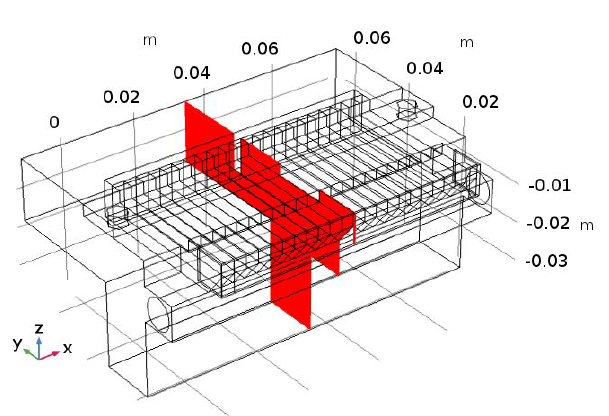
Figure 14. The position of the middle cross